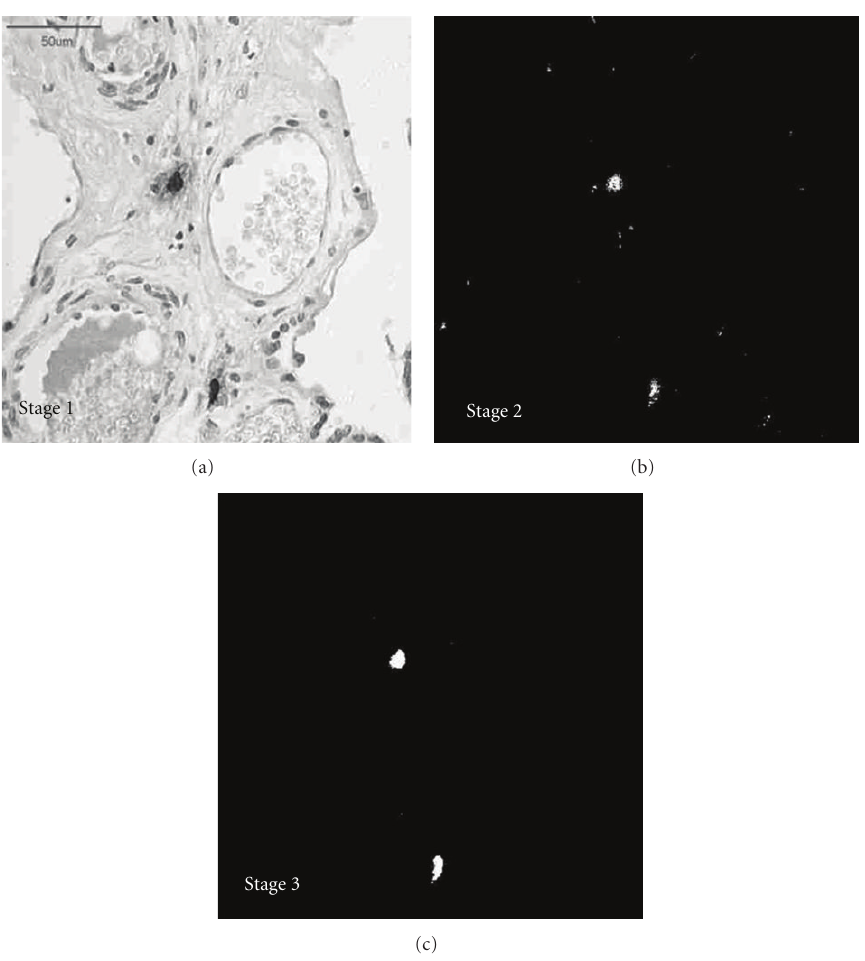
Figure 1: Process of mast cells identification with morphometric software. Stage 1: initial picture obtained from microscope and saved in HSI colour system. Stage 2: binary image after detection of mast cells in distinct hue values. Stage 3: final reduction of noises and smoothing of detected